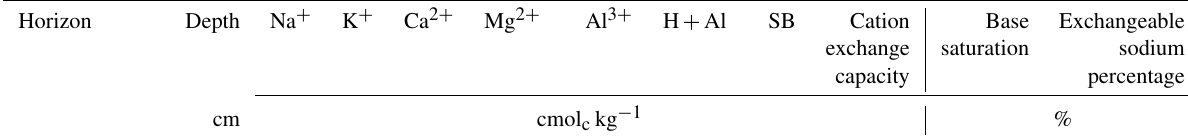
Table 3. Exchangeable cations of seagrass meadow soils from the Brazilian coast.